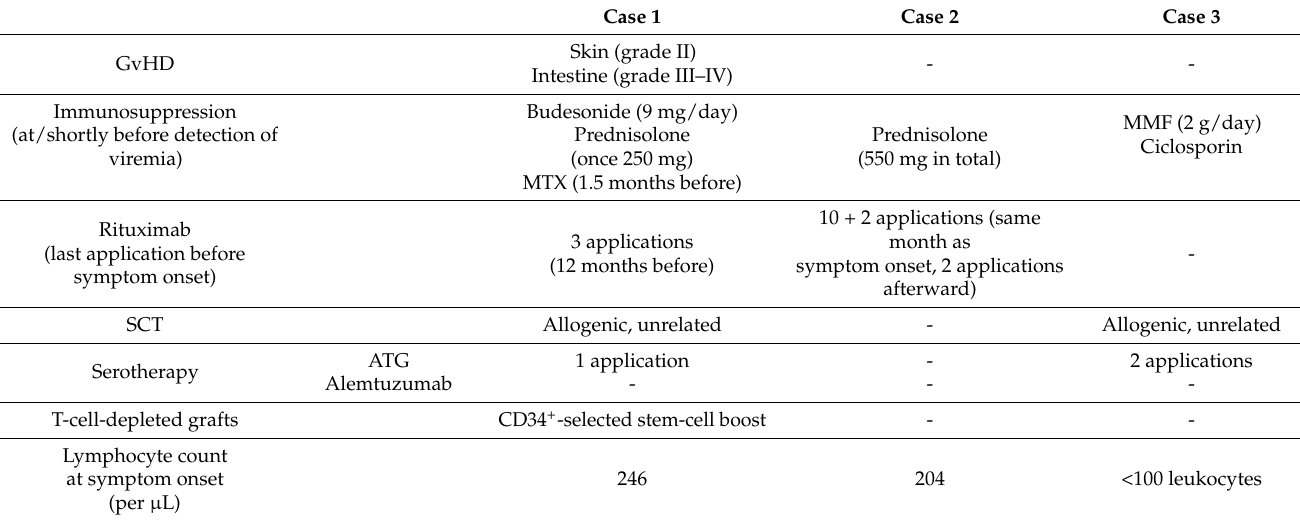
Table 2. Patients’ risk factors.